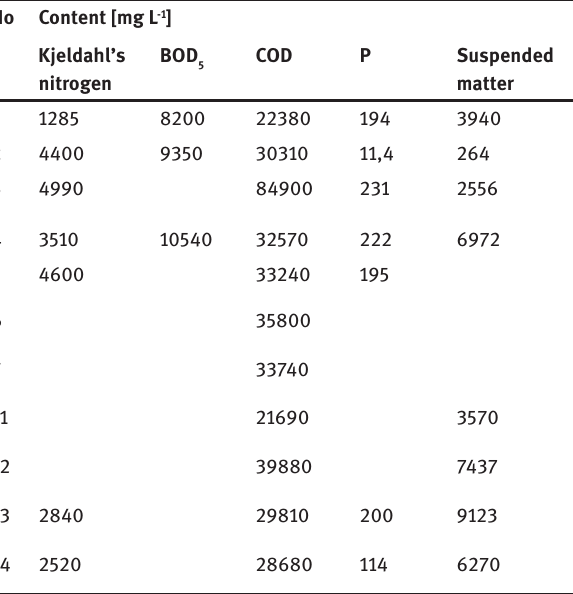
Figure 3: Quantitative analysis of sediment obtained after wastewater treatment with dose 3.0 mL PIX 113 per 1 L.